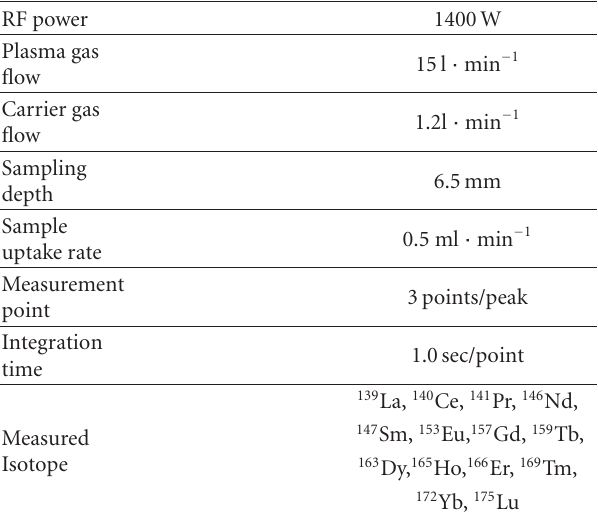
Table 1: Operating conditions of